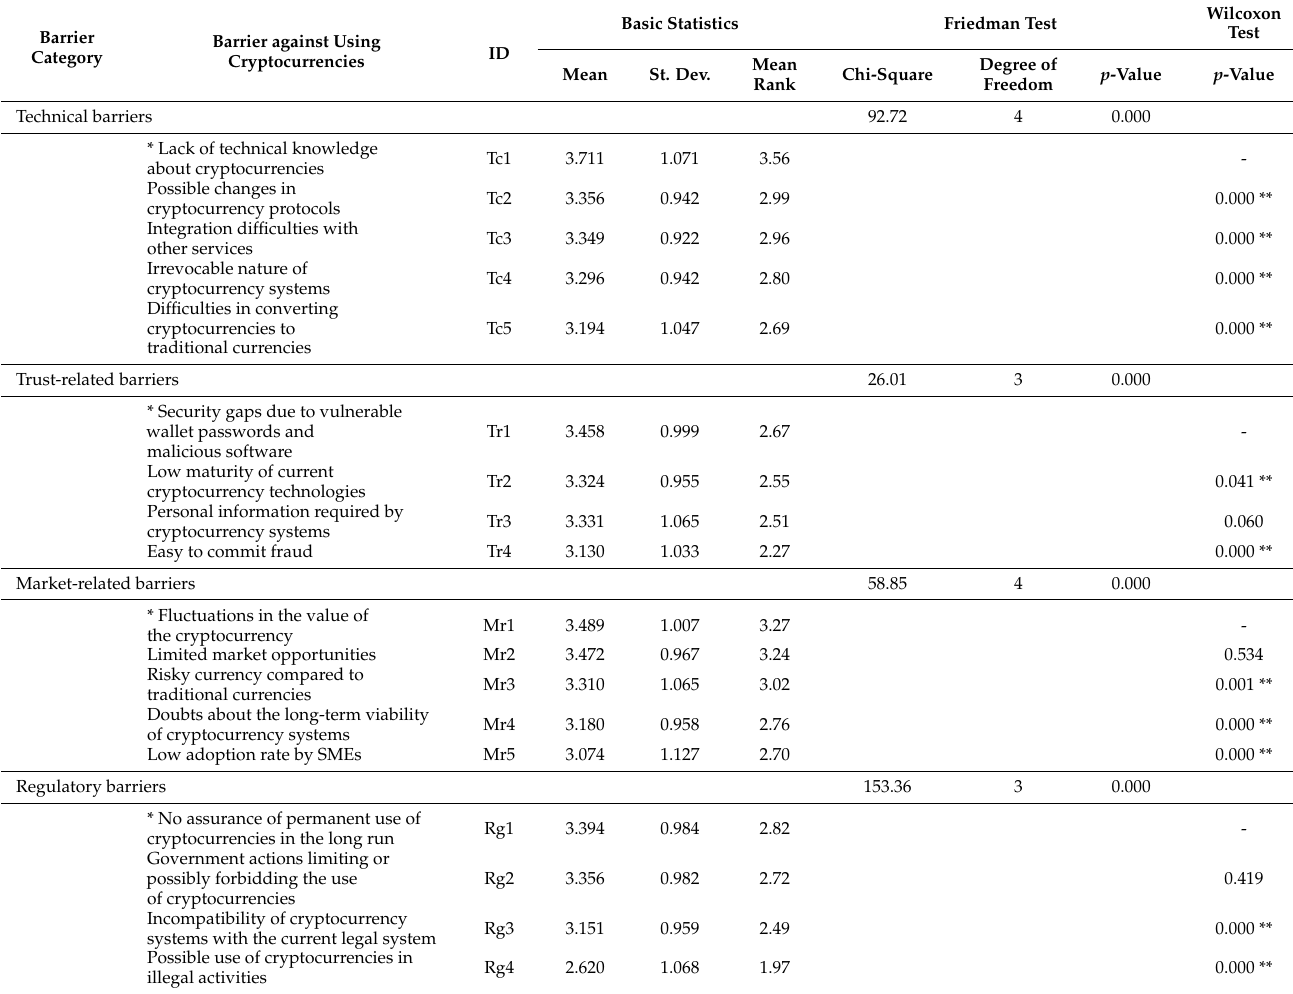
Table 3. Results of the Friedman test.